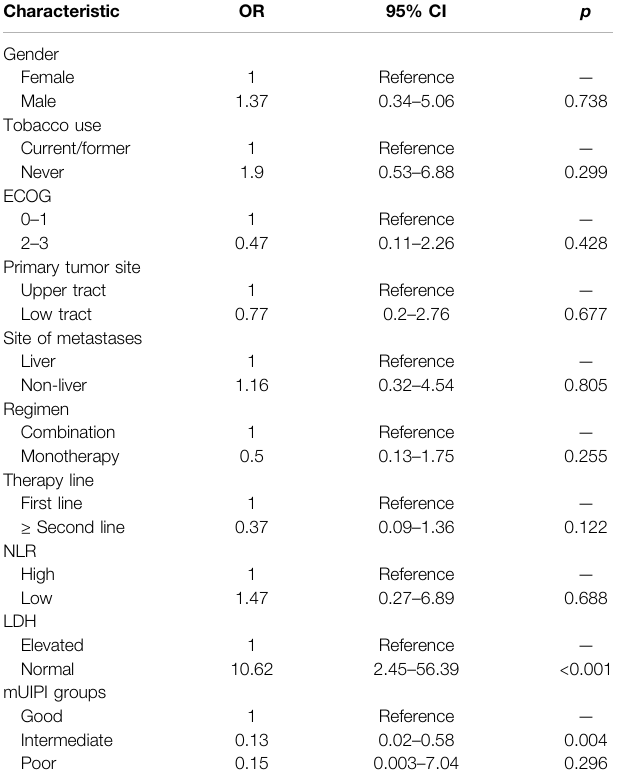
TABLE 2 | Ef fi cacy (DCR) analysis of included patients.